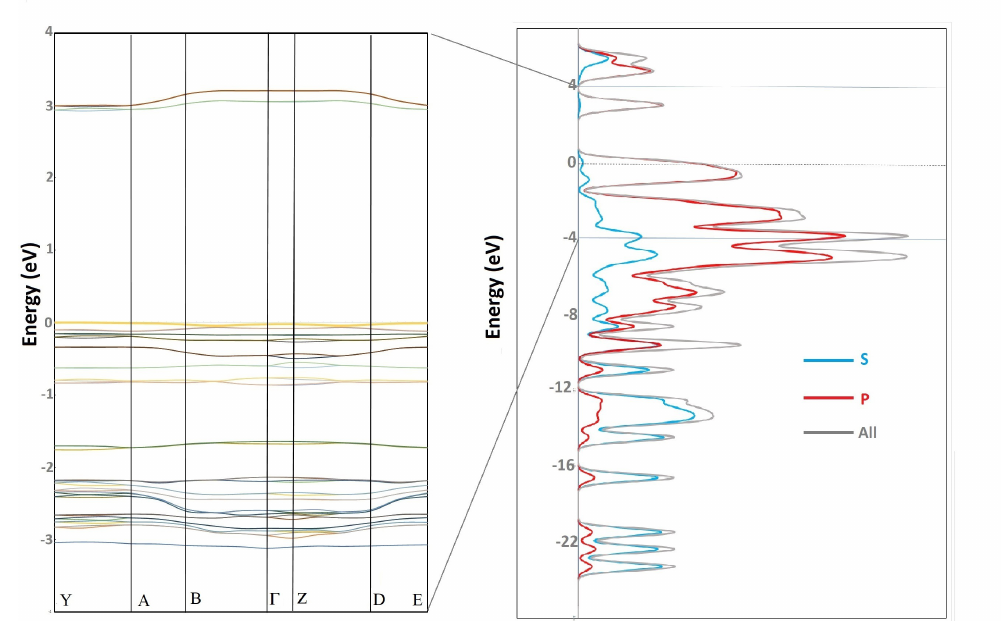
Figure A1. Band structure of the composite, indicating a band gap of 2.94 eV between the high symmetry points of the Y-A reciprocal lattice, the highest energy band below the Fermi level indicates 0